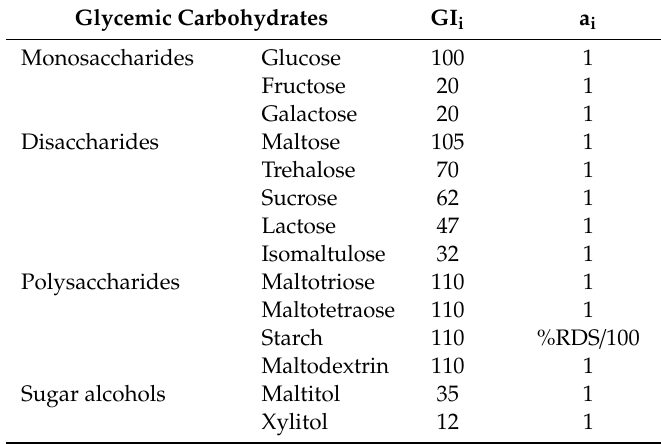
Table 2. Glycemic index (GI i ) and correcting factor (a i ) of common glycemic carbohydrates, including glycemic sugar